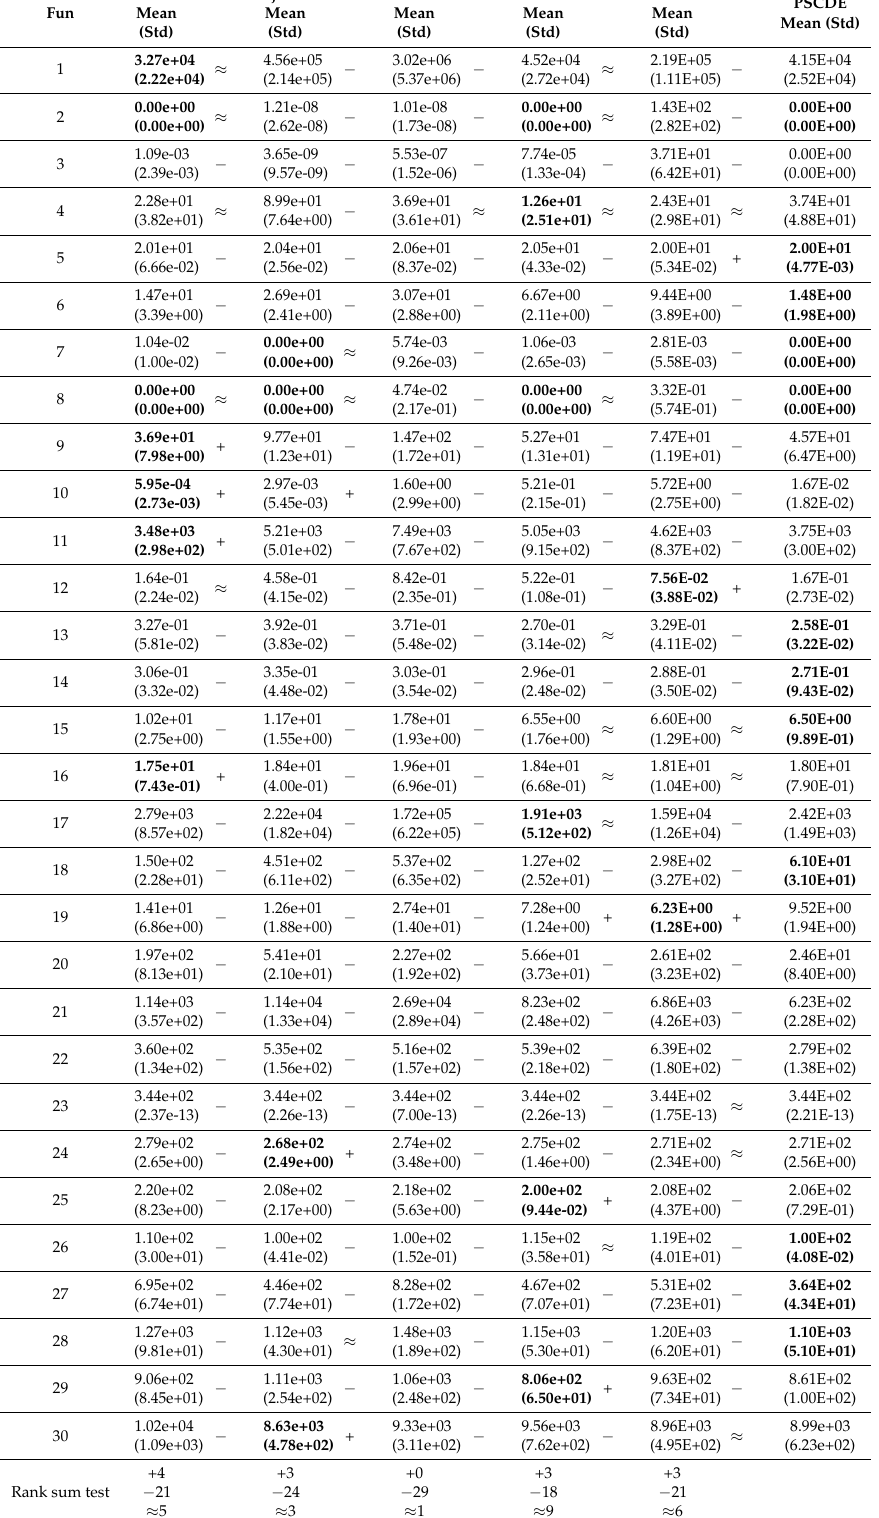
Table 6. CEC 2014 function test for 50D on SHADE, jDE, ESPDE, MPEDE, CoDE and PSCDE.